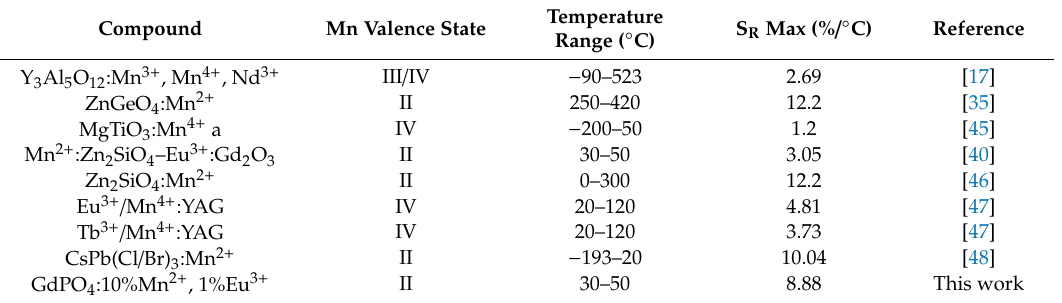
Table 1. Comparison of the parameters for di ff erent manganese-based luminescent thermometers.